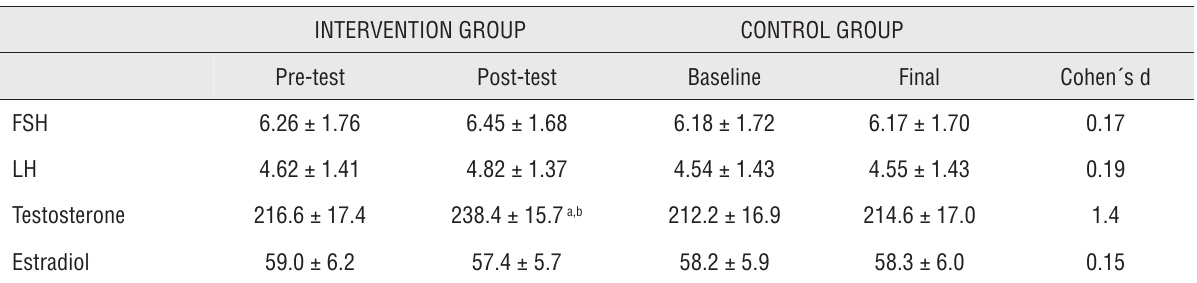
Table 2 - Reproductive hormone profiles in sedentary adults with chronic SCI enrolled in the intervention (n = 9) and control (n = 8)